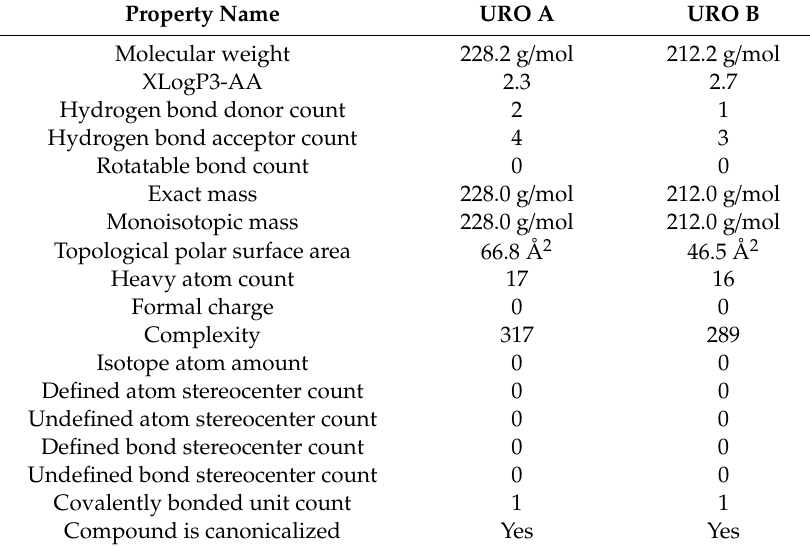
Table 10. Physicochemical computed properties of urolithin (URO) A and URO